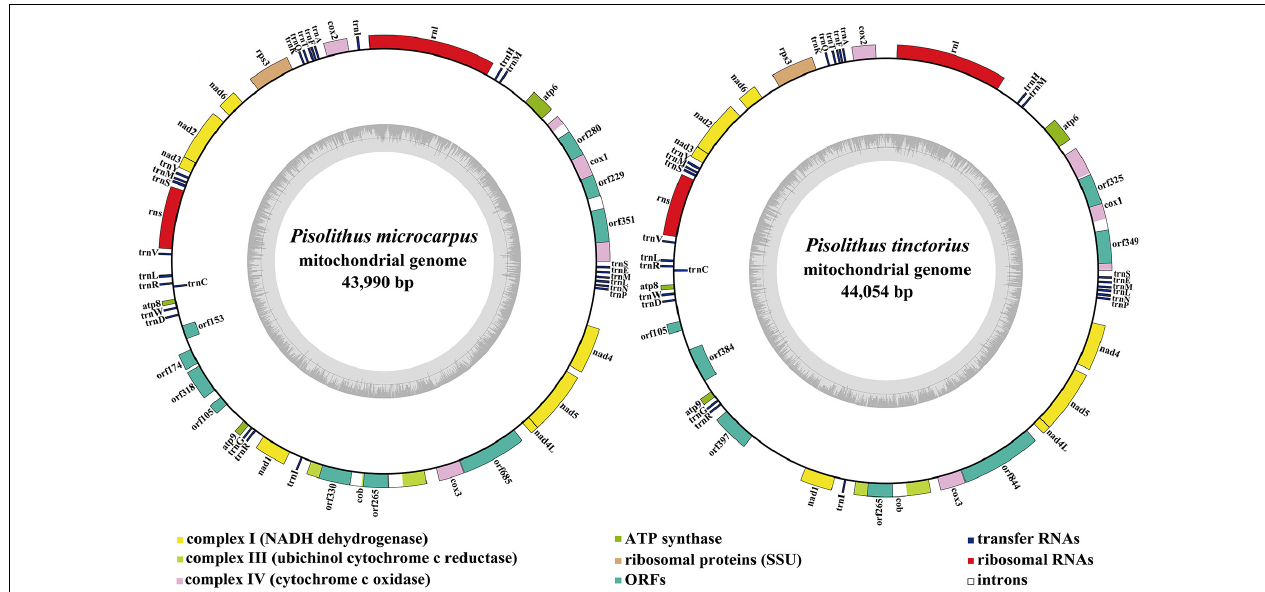
FIGURE 1 | Circular maps of the two Pisolithus mitogenomes. Genes are represented by different colored blocks. Colored blocks outside each ring indicate that the genes are on the direct strand, while colored blocks within the ring indicates that the genes are located on the reverse strand. The inner graph is the GC content of mitochondrial sequences, and the circle inside the GC content graph marks the 50% threshold.